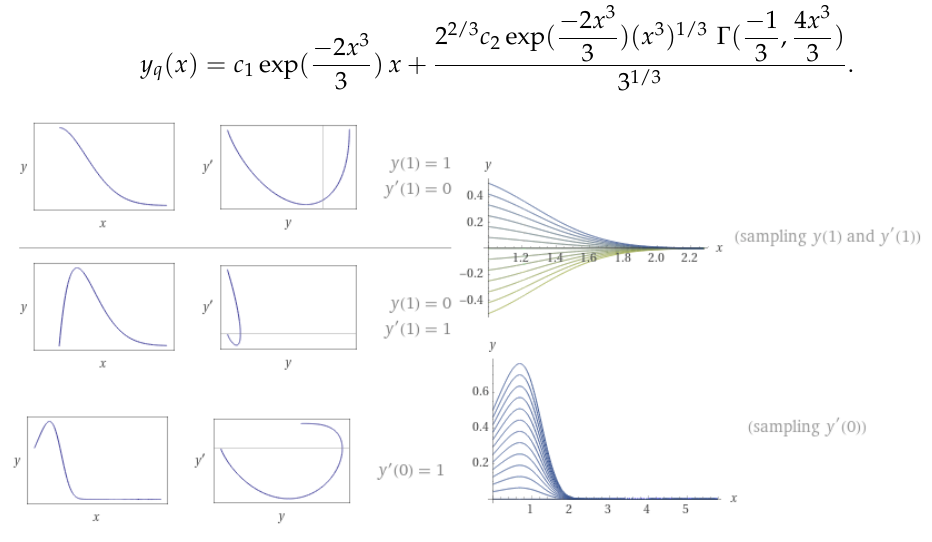
Figure 2. The solution of (14) for ℘ =